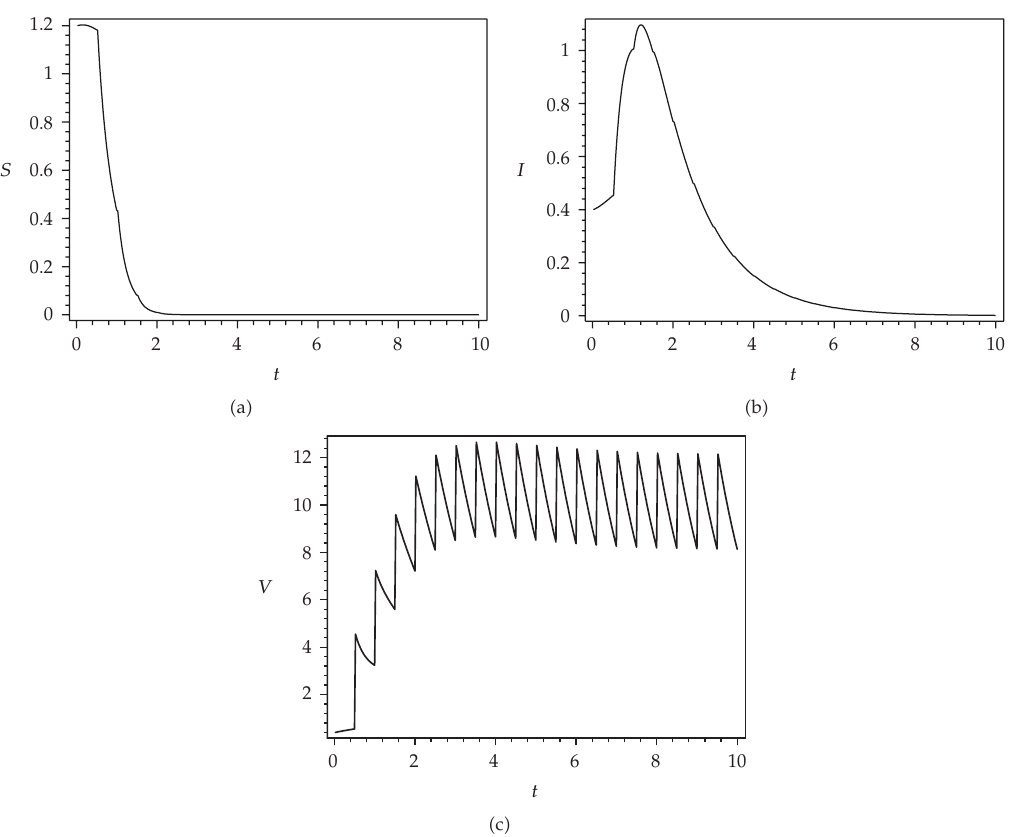
Figure 1: Dynamical behavior of the system (cid:4) 1.1 (cid:5) with r (cid:7) 1 . 8 ,K (cid:7) 2 ,θ (cid:7) 0 . 6 ,β (cid:7) 0 . 2 ,p (cid:7) 4 ,λ (cid:7) 0 . 8 ,μ (cid:7) 0 . 8 ,b (cid:7) 3, and T (cid:7) 0 . 5